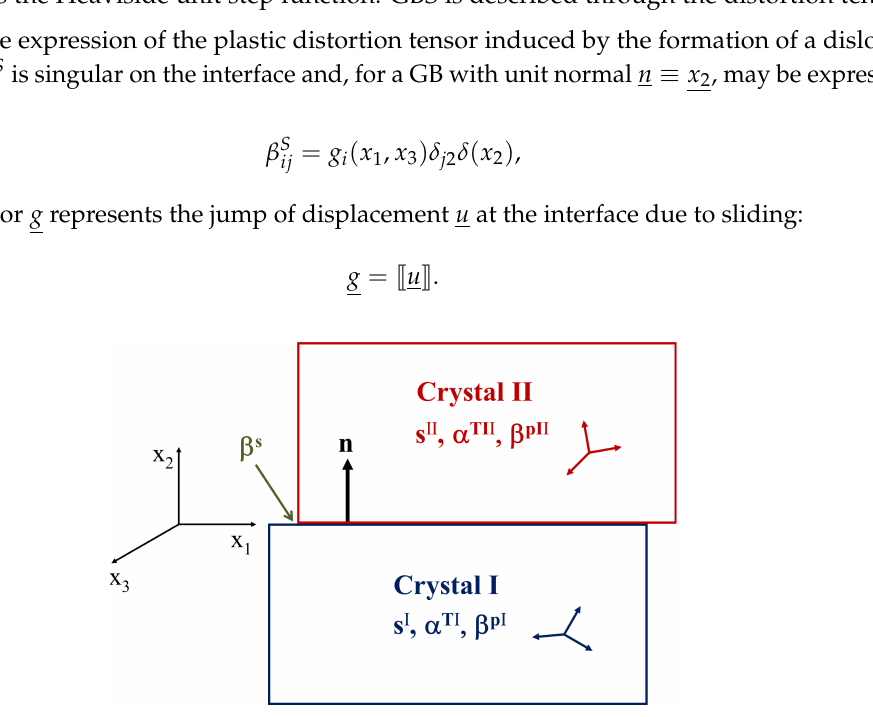
Figure 1. Infinite planar grain boundary exhibiting GBS (see text for